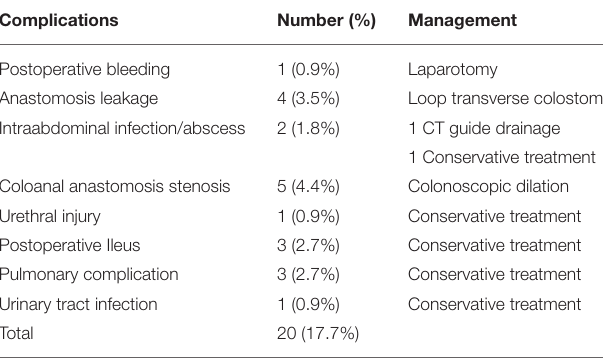
TABLE 1 | Baseline characteristics and perioperative outcomes of 113 patients with rectal or sigmoid colon cancer who underwent totally robotic-assisted TME with the high dissection and selective ligation technique.